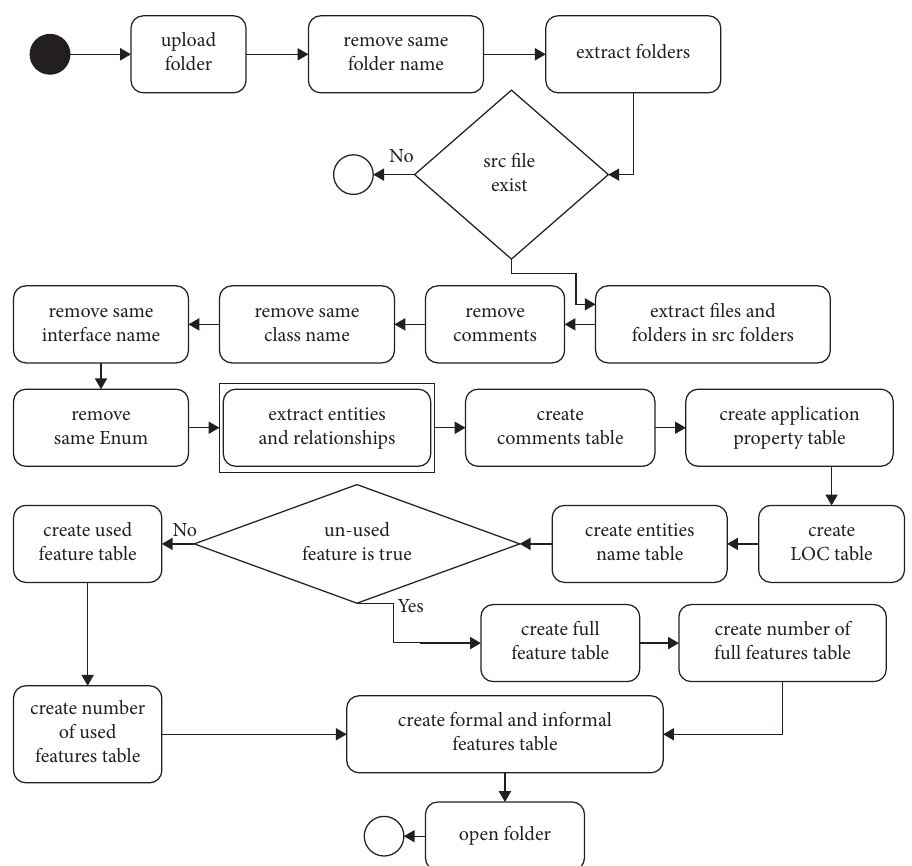
Figure 1: Process of fact